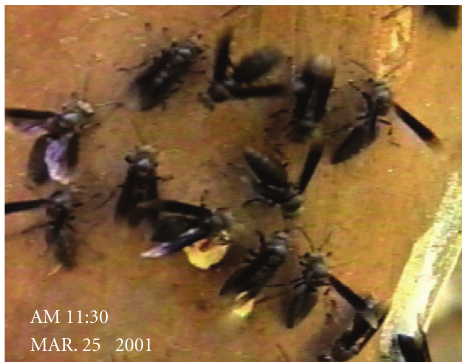
Figure 1: Cluster of scouts of Pa. fraternus from colony C2 visiting a selected new nest site and gaster-dragging on the substrate surface during pre-emigration.